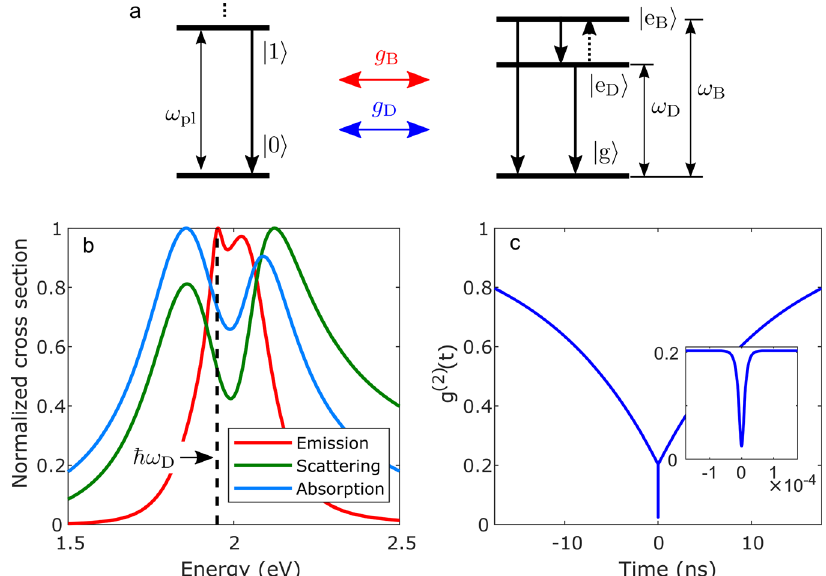
Fig. 4 Quantum simulations of the plasmon-QD coupling dynamics. a Schematic level diagram describing the theoretical model. The plasmonic cavity is depicted on the left with an excited state of energy ω pl : The QD (right) is described as a three-level electronic system containing a ground state j g i , a bright excitonic level, j e B i , and a dark excitonic level, j e D i . The bright (dark) excitonic transition occurs at energy ω B ( ω D ). For the PL spectrum. we assume that both the bright and the dark excitons are pumped incoherently. Plasmon – exciton coupling is described within the Jaynes – Cummings model with rates g B and g D (for coupling of the bright and dark exciton, respectively). A detailed description of the model terms is provided in the Methods section, and the parameters used are given in Table 1. b Emission (red), scattering (green), and absorption (blue) spectra calculated theoretically for parameters shown in Table 1. The dashed line marks the energy of the dark exciton, _ ω D . c A simulated g (2) ( t ) features a two-component decay. Inset shows a zoom of the fast (fs) decay of the system excitations that is not resolved on the ns time scale.